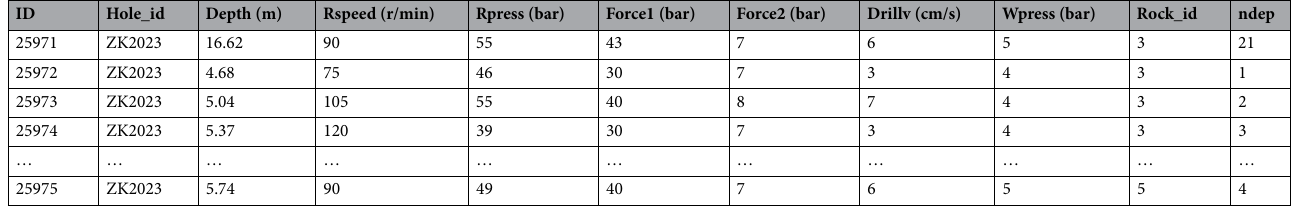
Table 3. Blast hole data